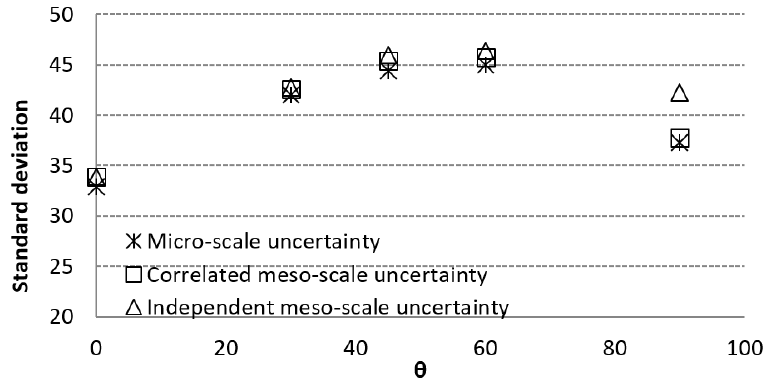
Figure 6. Standard deviation of first order natural frequency of ( ± θ ) 4 laminate cylindrical shell derived by considering different uncertainty.